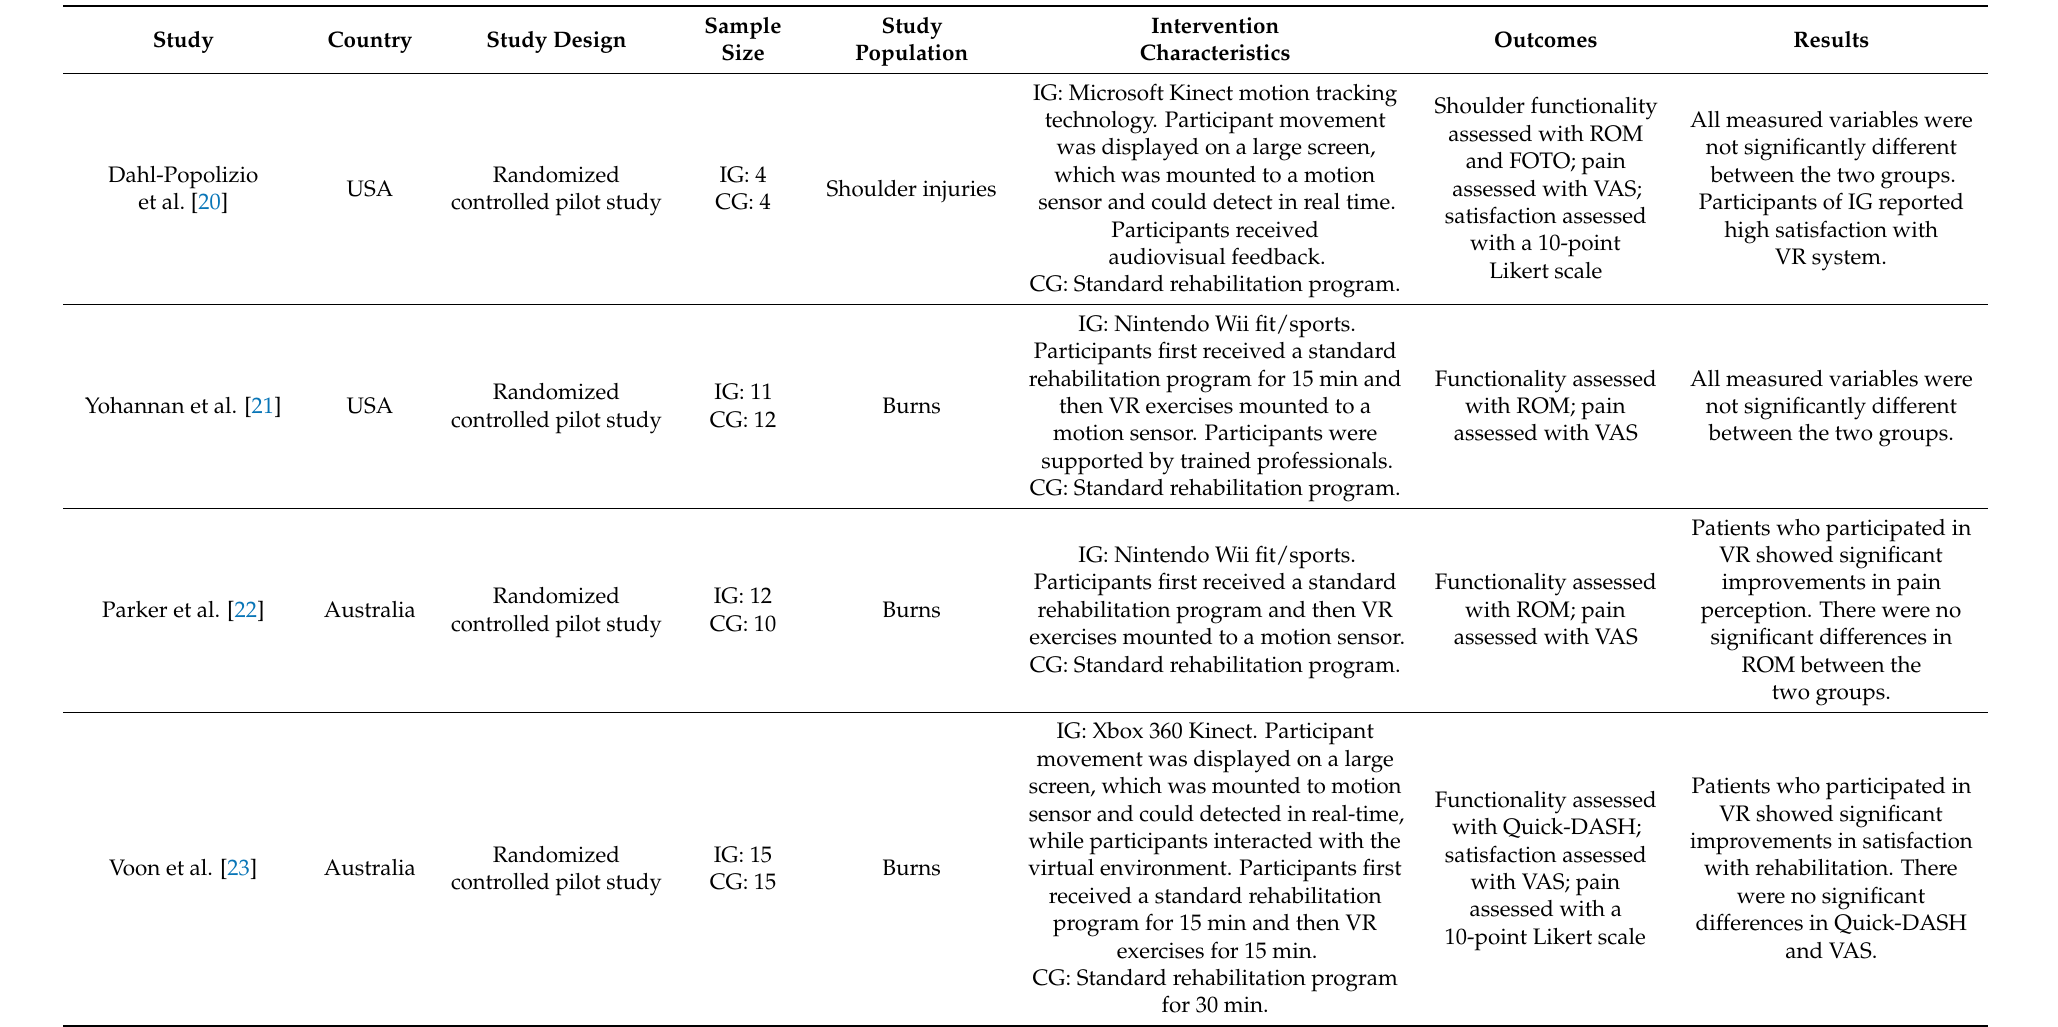
Table 1. Characteristics of included